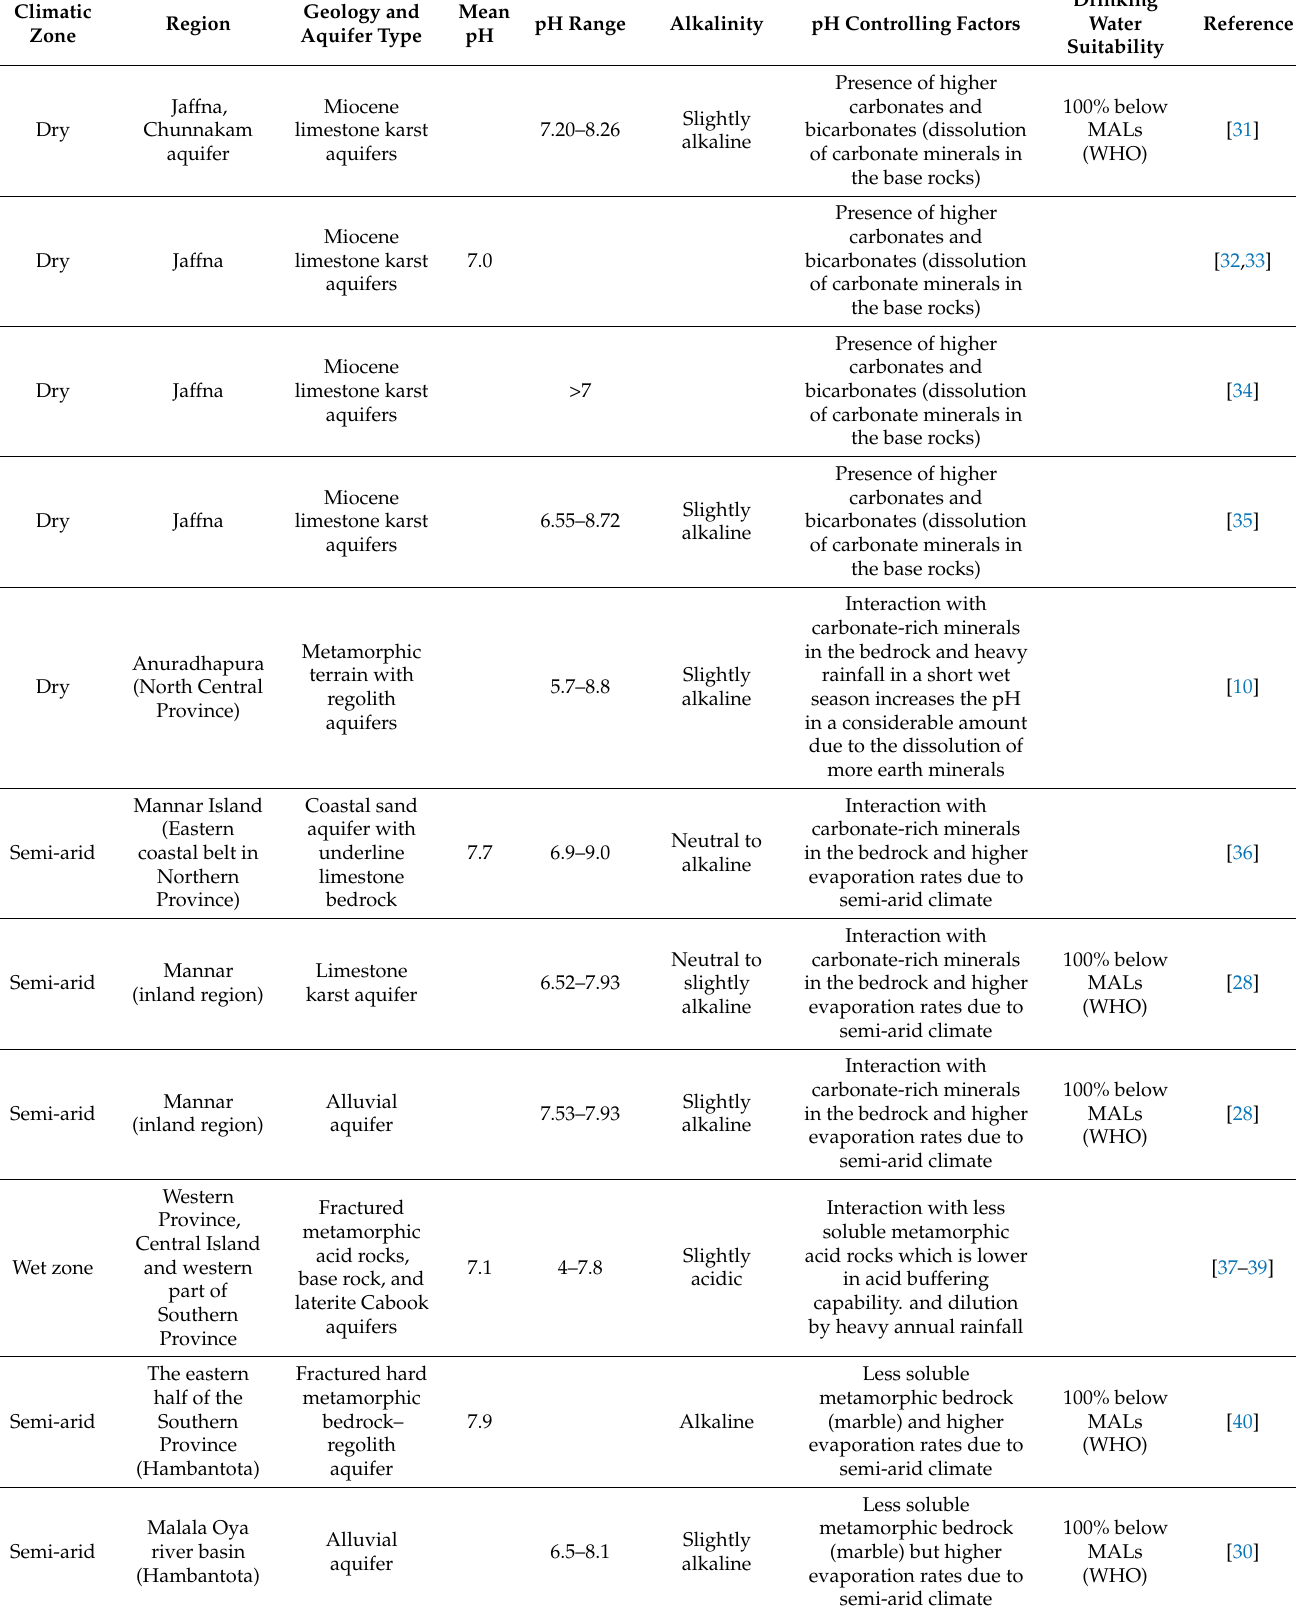
Table 2. Alkaline nature and the pH levels of groundwater in different climatic regions of Sri